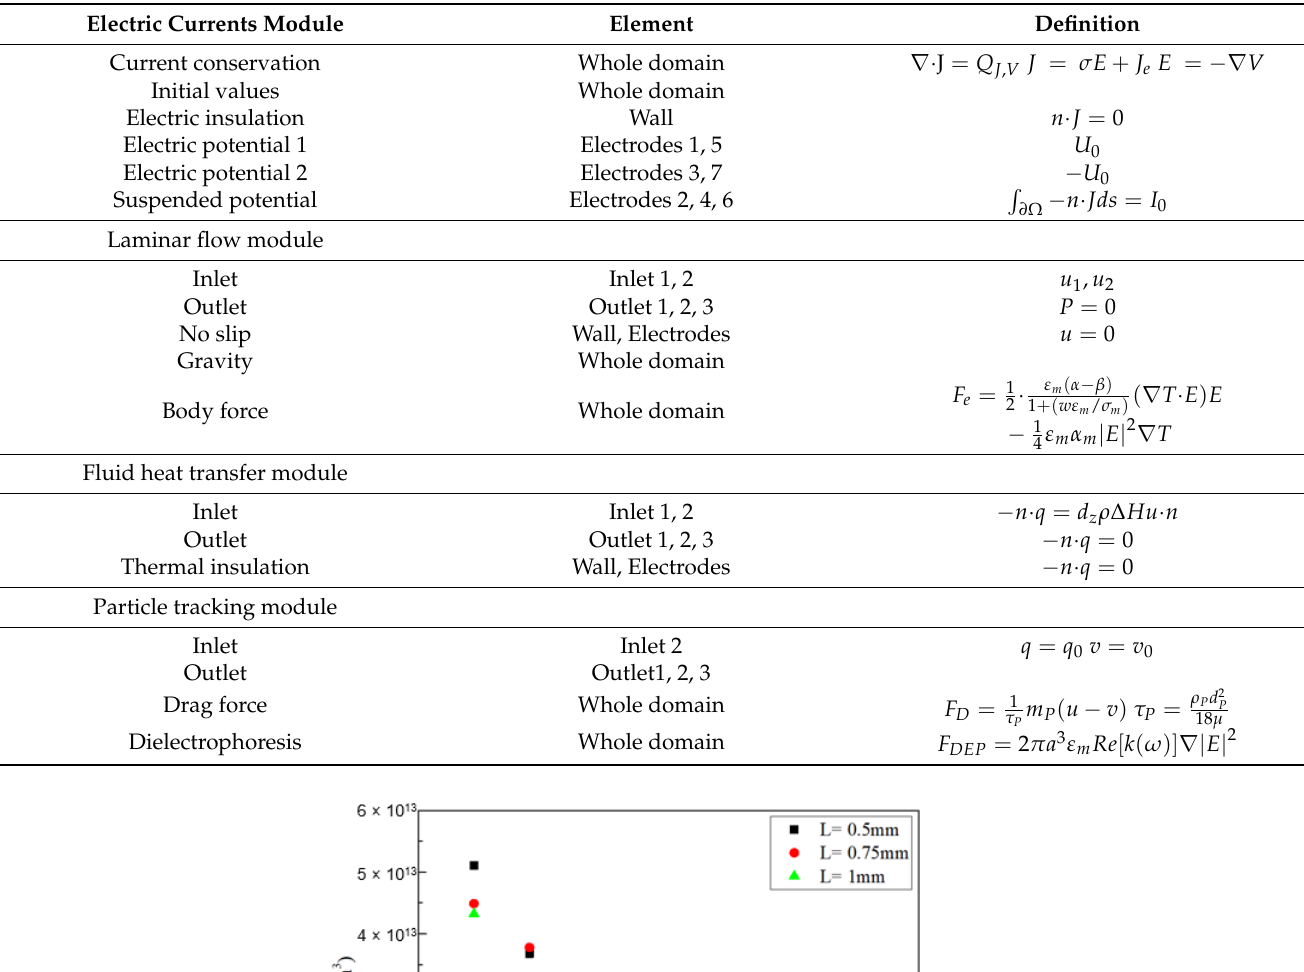
Table A2. Computation domain and boundary conditions employed in COMSOL Multiphysics.